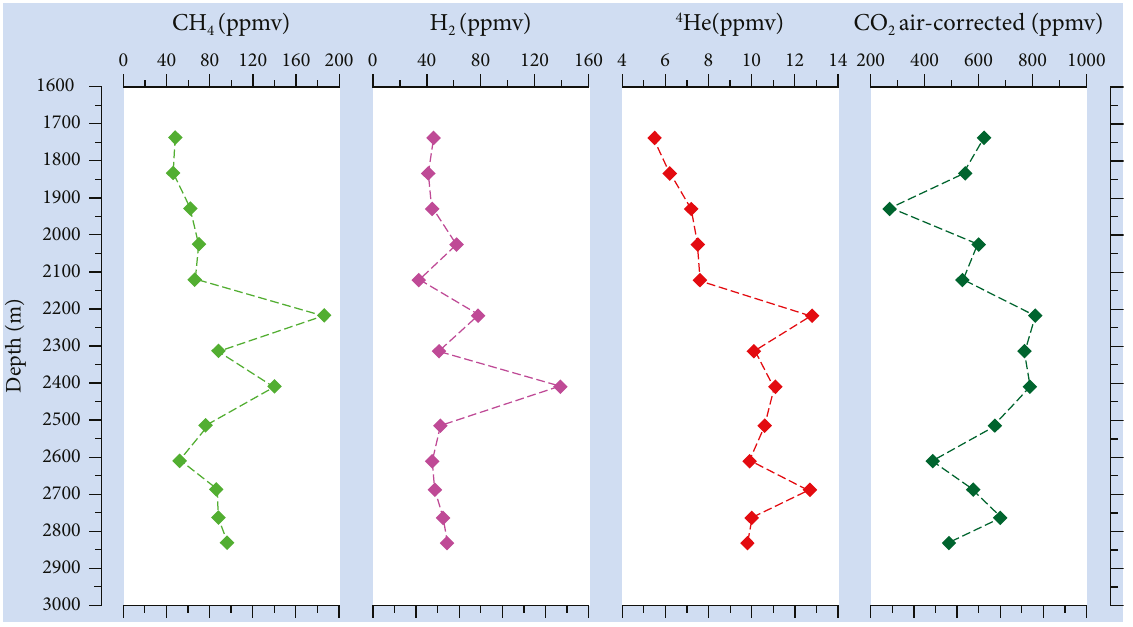
Figure 4: Plot showing concentration versus depth pro fi les of CH during water fl ushing after core run